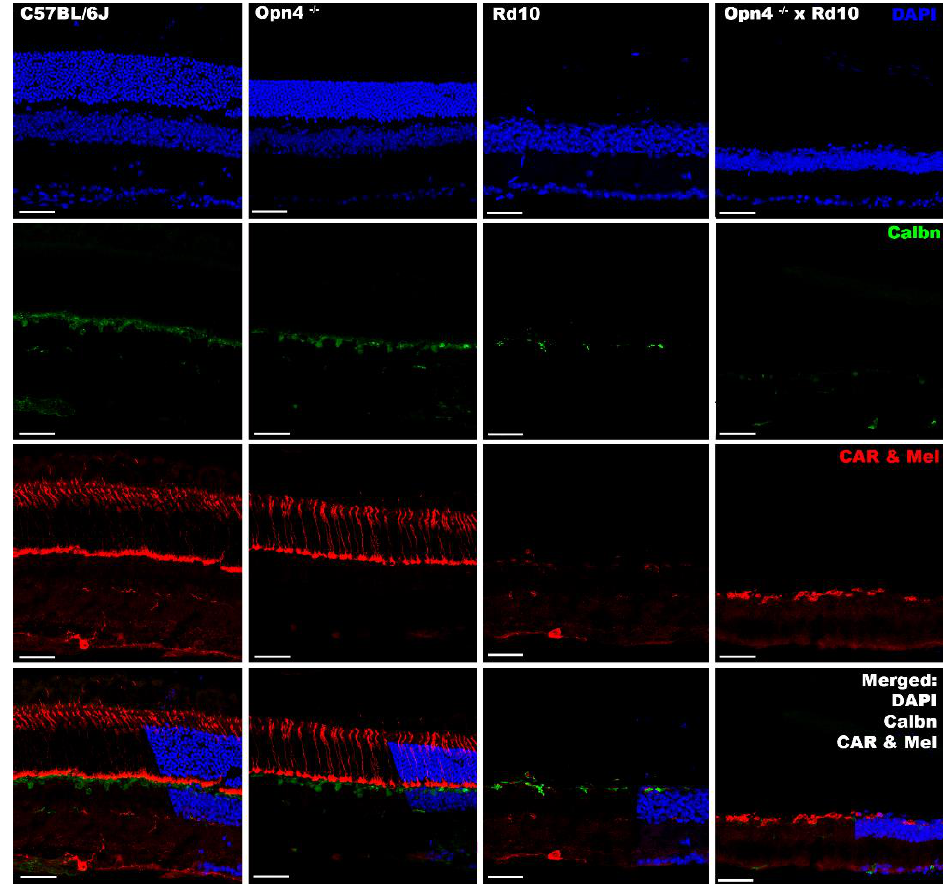
Figure 7. Immunohistochemical labeling of cones and ipRGCs in different models. From left to right, the different animal models are presented (C57BL/6J; Opn4 − / − ; Rd10; Opn4 − / − × Rd10). From top to bottom, the different agents and antibodies used are presented. DAPI : intercalating marker of cell nuclei; Calbindin (Calbn) : protein located in the horizontal cells; Cone Arrestin (CAR) : cone labeler; Melanopsin (Mel) : melanopsin labeler, located in the ipRGCs; ipRGCs are marked by white arrowhead. The bottom row shows: “ Merged ” of different labelings. Opn4 − / − × Rd10 animal model showed total absence of cells with photosensitive capacities. The scale bar indicates 50 µm.